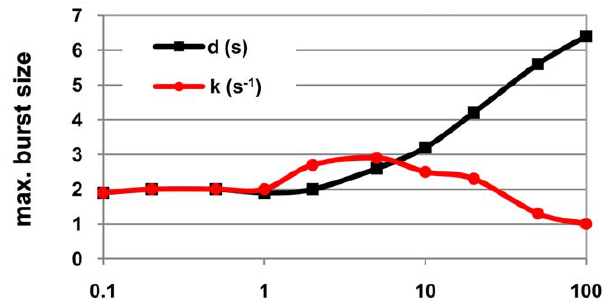
Figure 3. Maximum microburst size as a function of the kinetics of pausing. Average size of the largest RNA microburst, over 10 cells, for various values of k pause (s 2 1 ) and d pause (s).